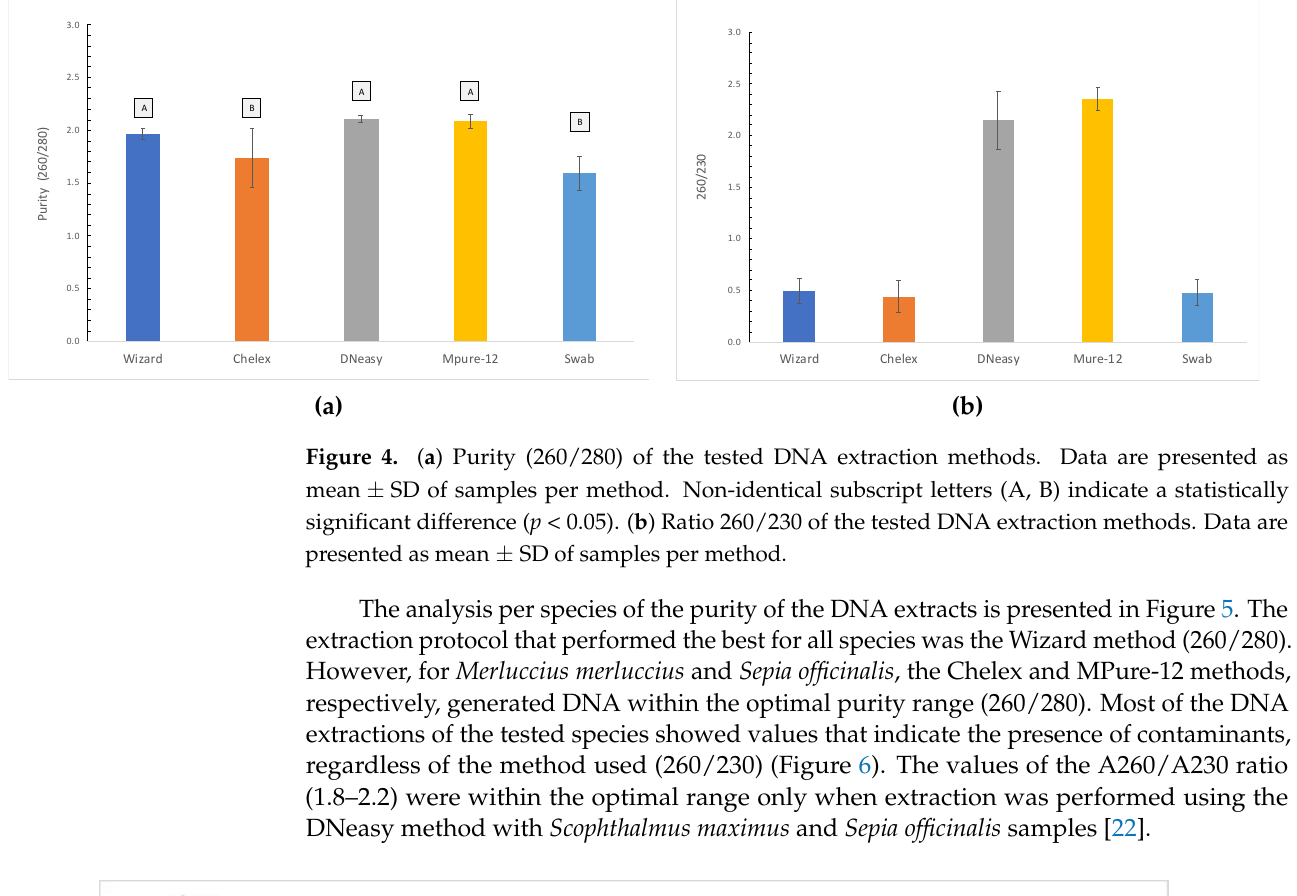
luccius (MMER), Sepia officinalis (SOFF) and Gadus morhua (GMOR).